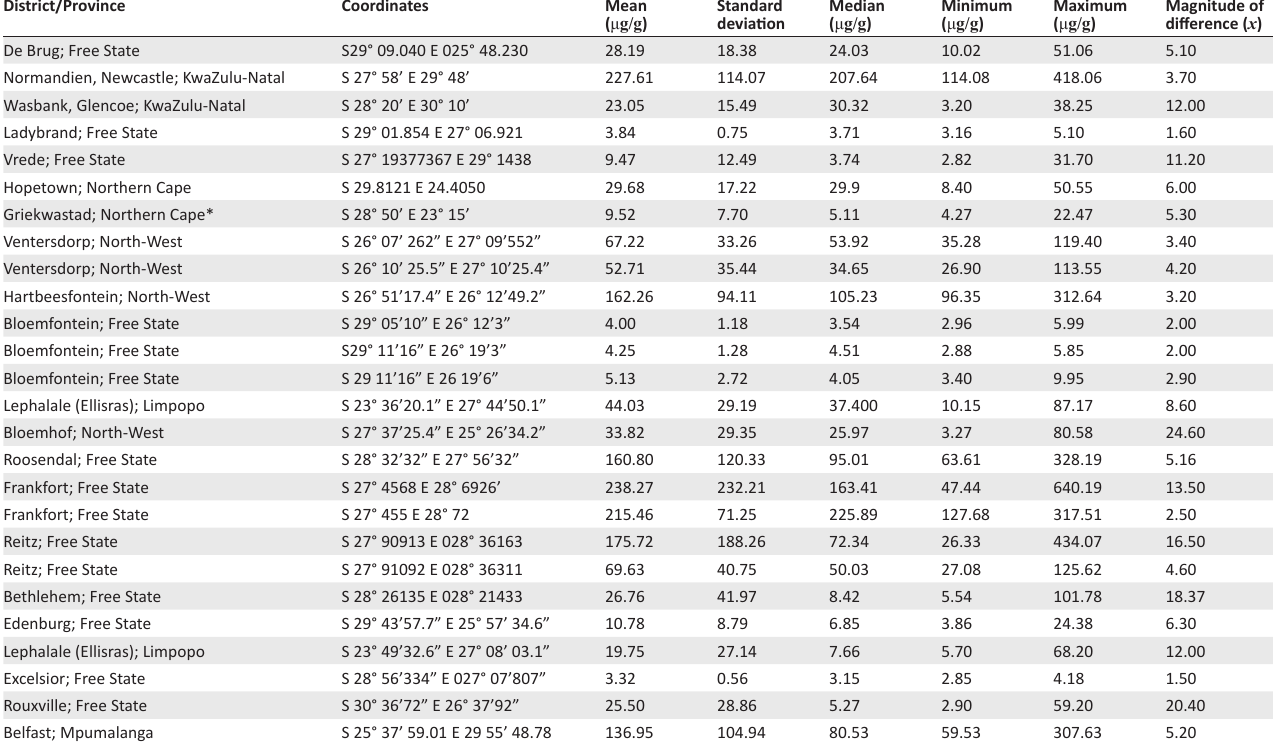
Standard Median Minimum Maximum Magnitude of ( μ g/g ) deviation ( μ g/g ) ( μ g/g ) ( μ g/g ) difference ( x )